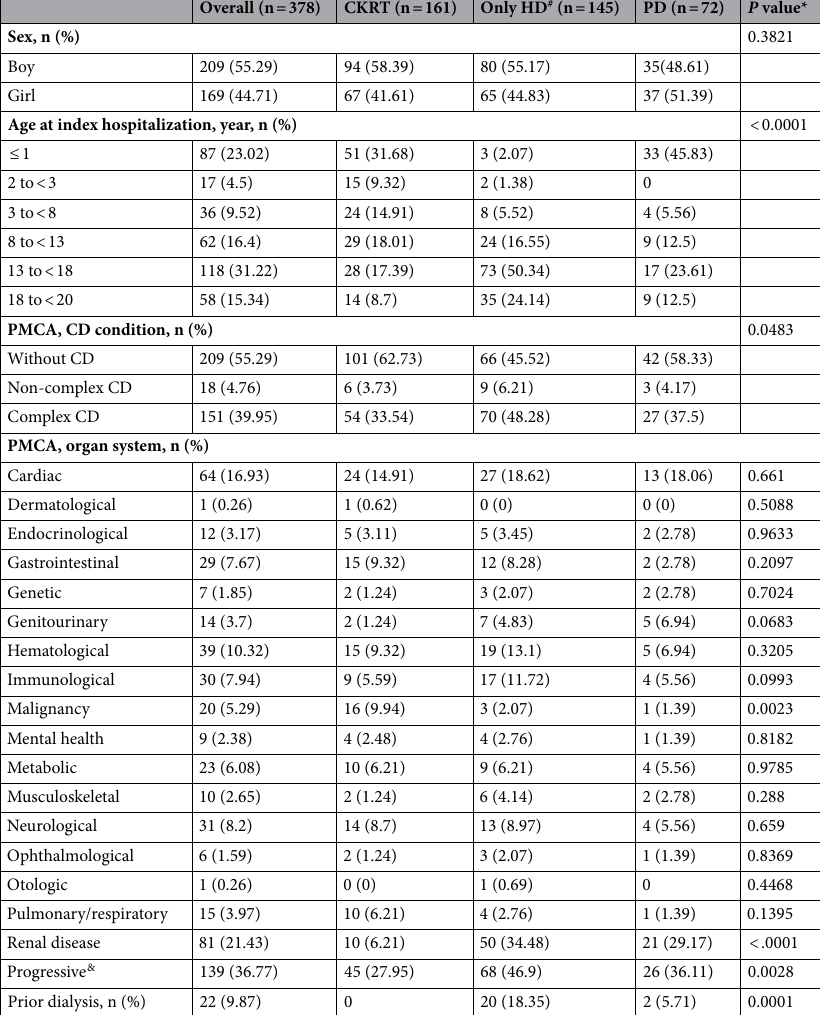
Table 1. Characteristics of hospitalized pediatric patients (n = 378). CKRT continuous kidney replacement therapy, HD hemodialysis, PD peritoneal dialysis, PMCA pediatric medical complexity algorithm, CD chronic disease. *P value indicates difference among three dialysis modality groups. # Some children received more than one dialysis modalities in the index hospitalization. The CKRT group included some patients receiving CKRT + HD; The PD group included some patients receiving PD + HD. $ PMCA and prior dialysis were ascertained among patients with any visits in the study setting 365 days prior to the index hospitalization. & A progressive condition associated with decreased life expectancy (e.g., muscular dystrophy), malignancy, or continuous technology dependence (e.g., dialysis or